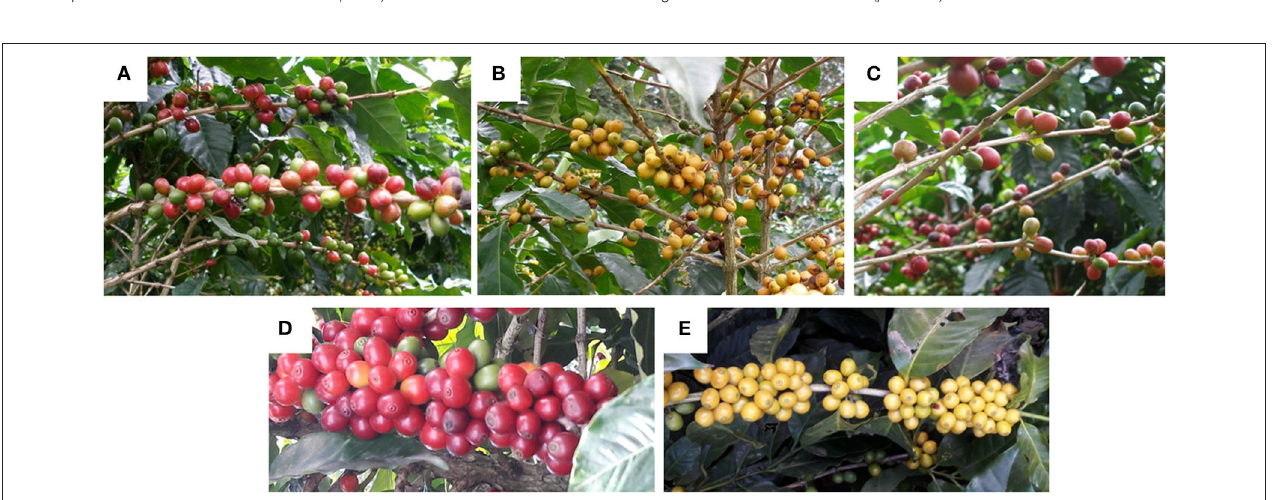
β -carotene (20–25%), as well as violaxanthin and neoxanthin (both 10–15%) (Schweiggert and Carle,